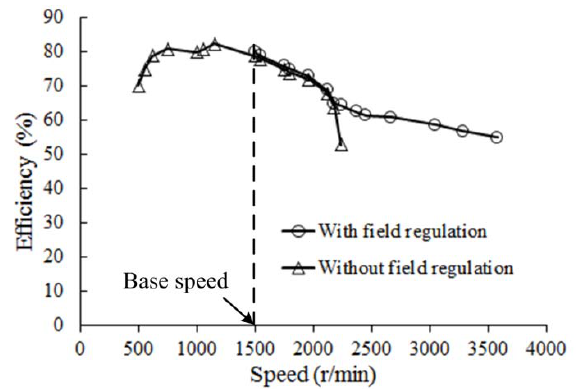
Figure 8. The effect of DC field regulation on the motor efficiency.